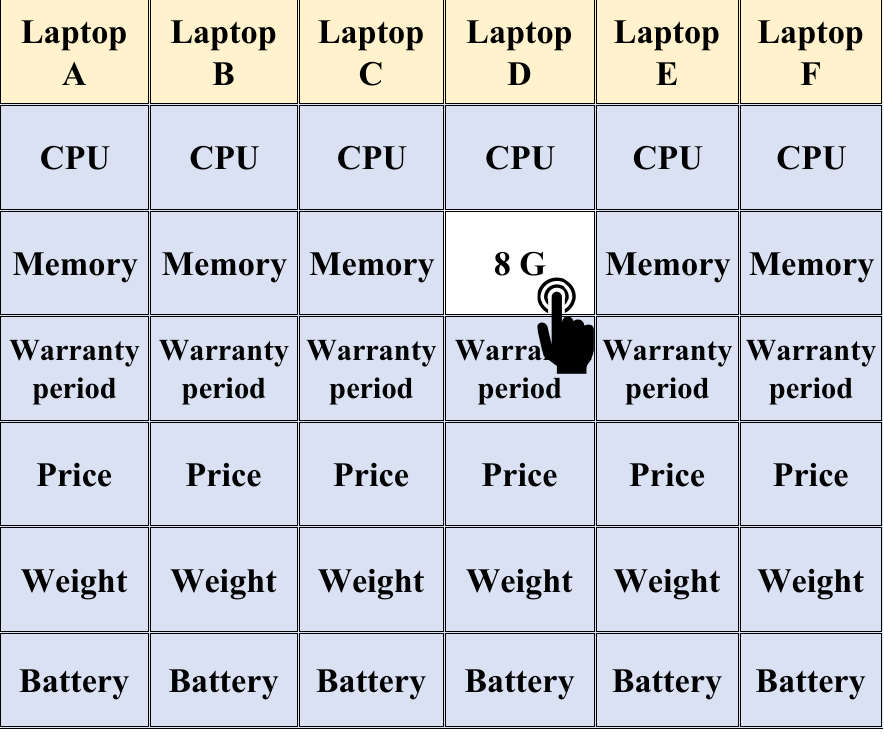
Figure A21. Example of stimulus presentation